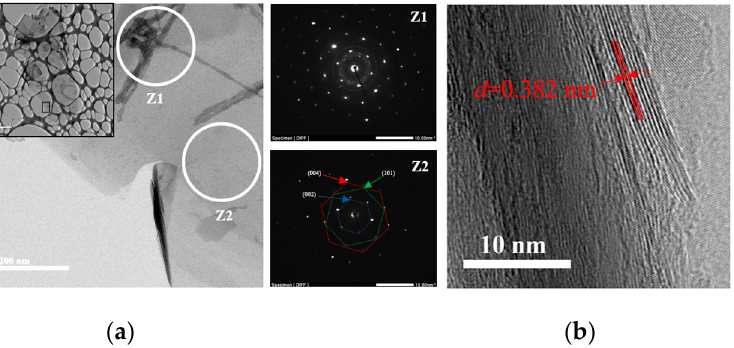
Figure 12. TEM micrographs and SAED patterns of the 0–2 sample after the expansion process ( a ) and HRTEM image with an interplanar measurement ( b ).